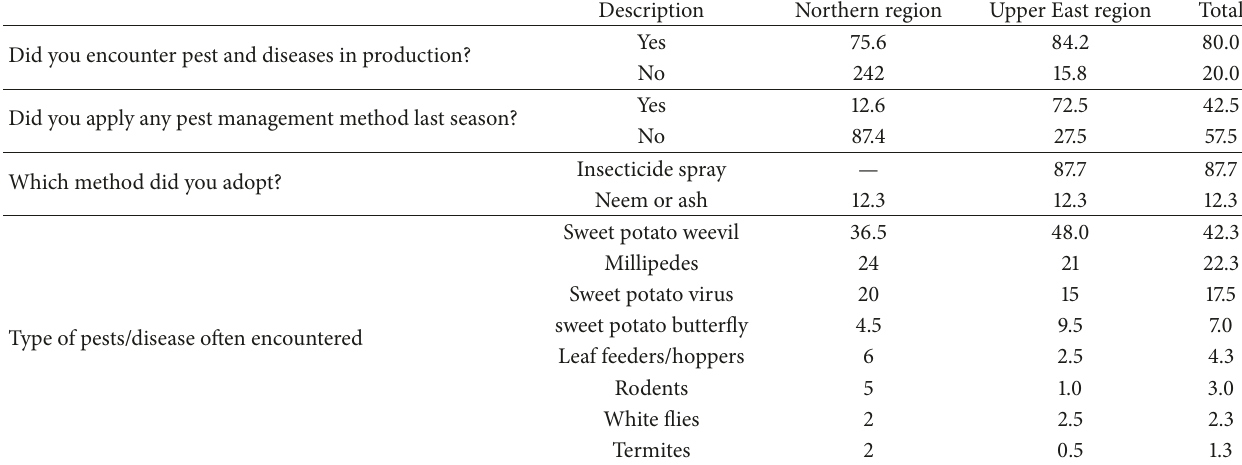
Table 6: Integrated pest management strategies adopted by growers (%